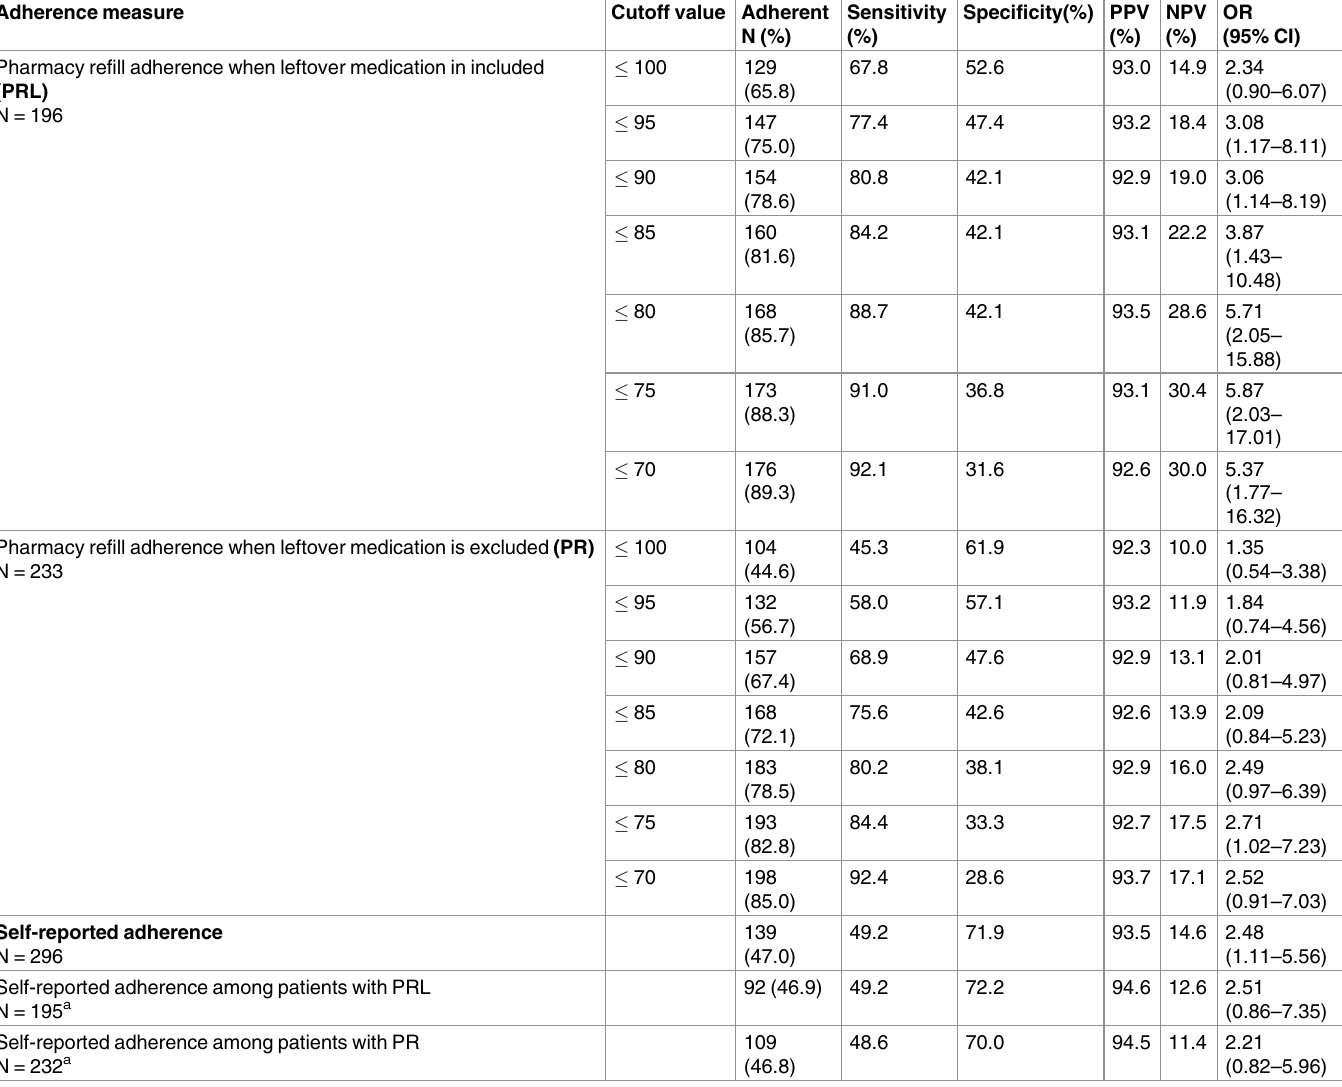
Table 2. Comparison of adherence